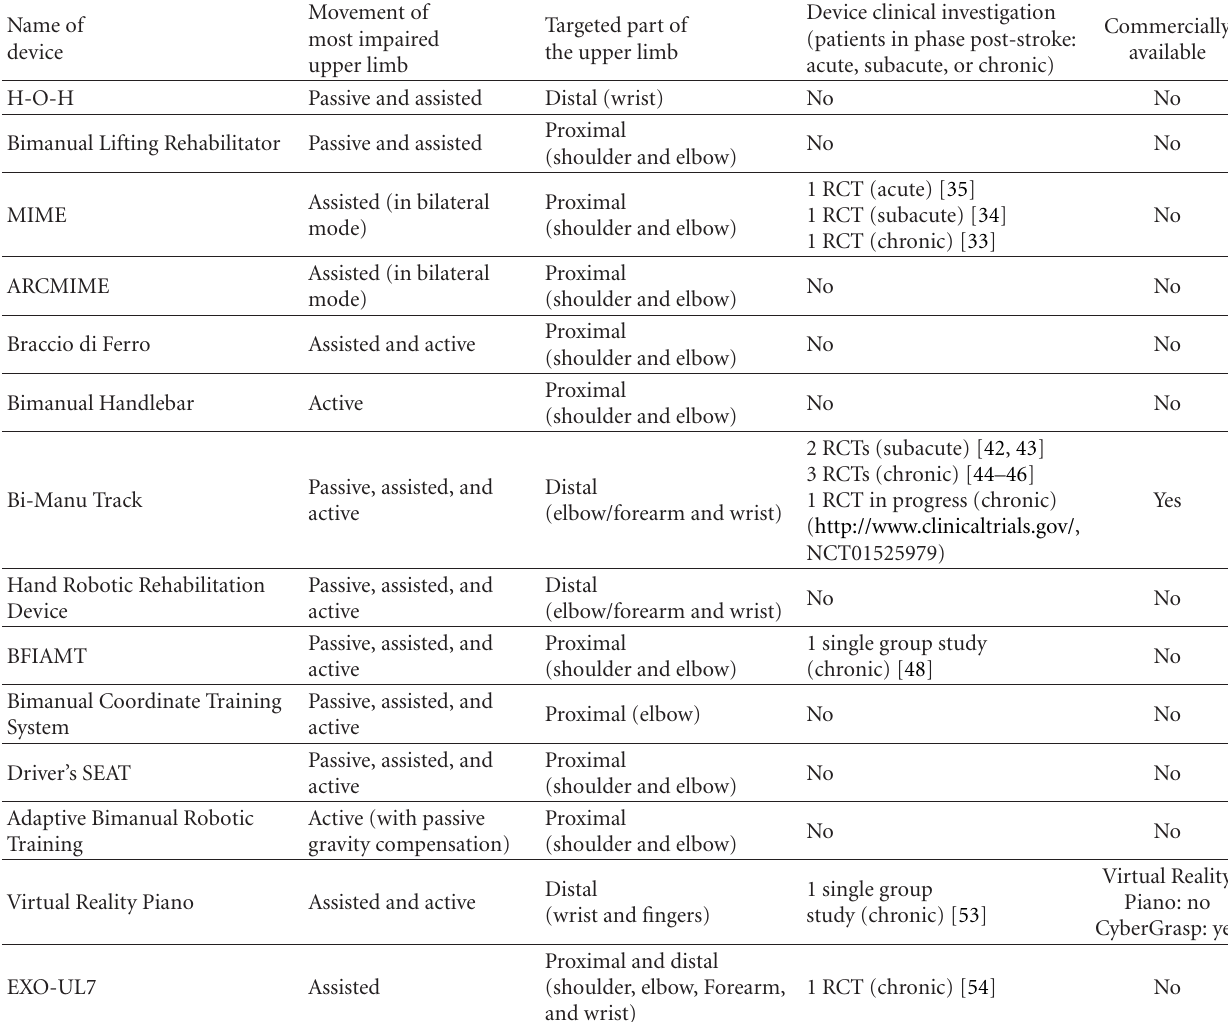
Table 2: Summary of robotic bilateral upper limb training